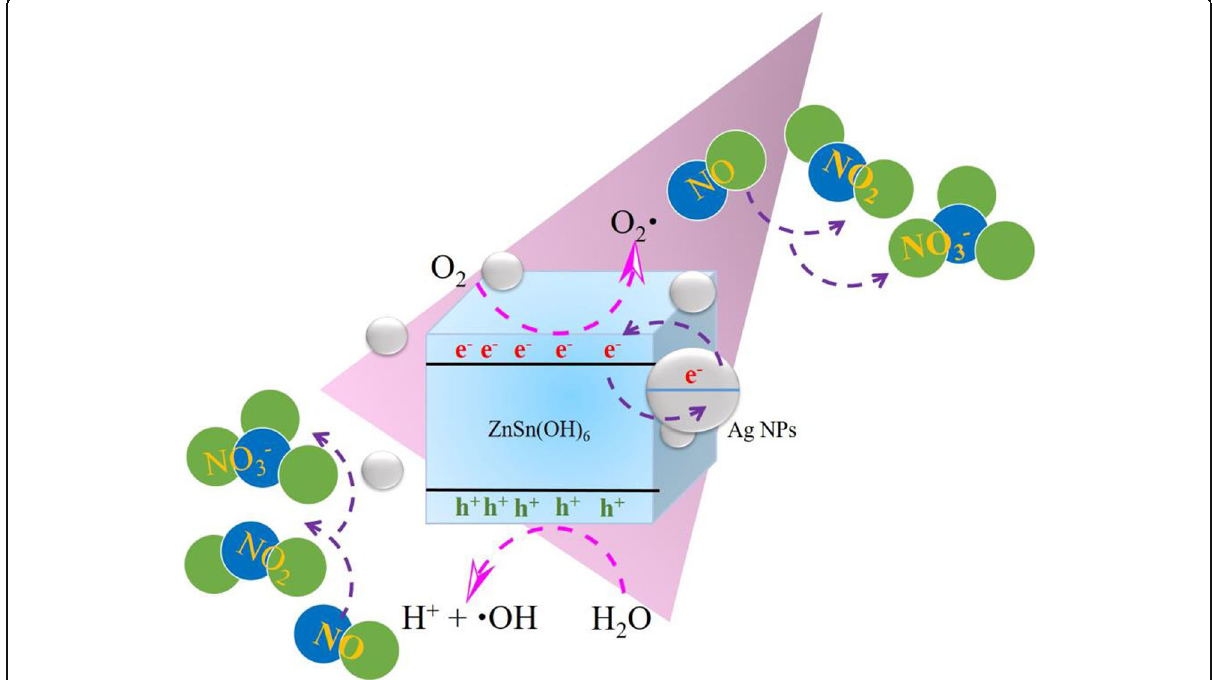
Fig. 10 Schematic of photocatalytic reactions of the Ag:cZHS to treat NO